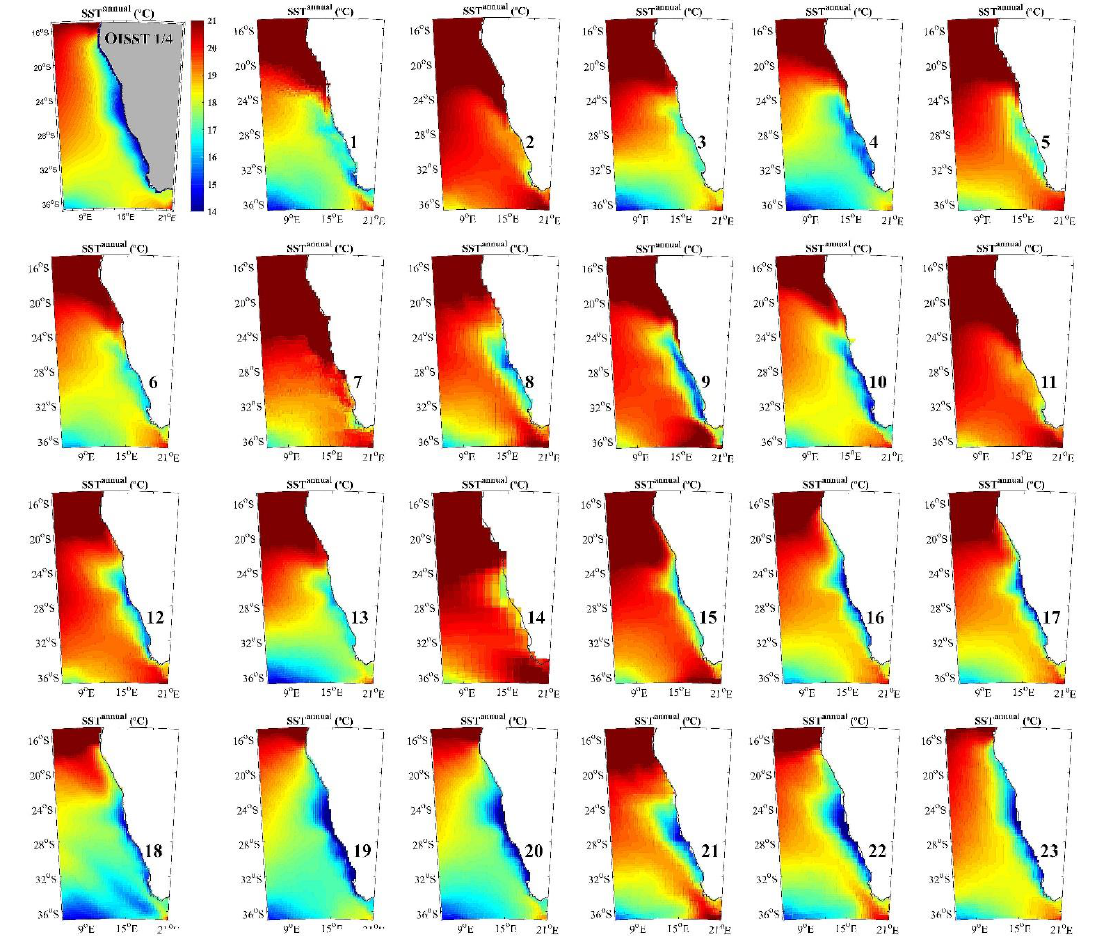
Figure 2. Mean of the annual SST (°C) for the Benguela upwelling system from 1982 to 2014. The numbers of each map refer to Table 1.